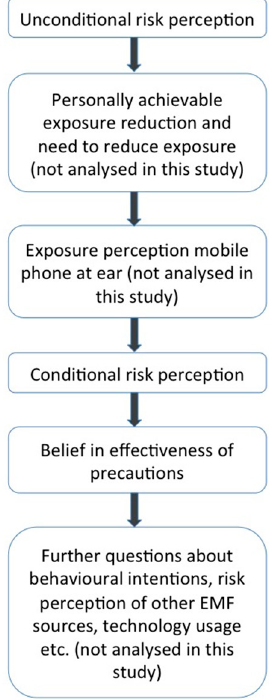
Figure 1. Flowchart of the course of the questionnaire.